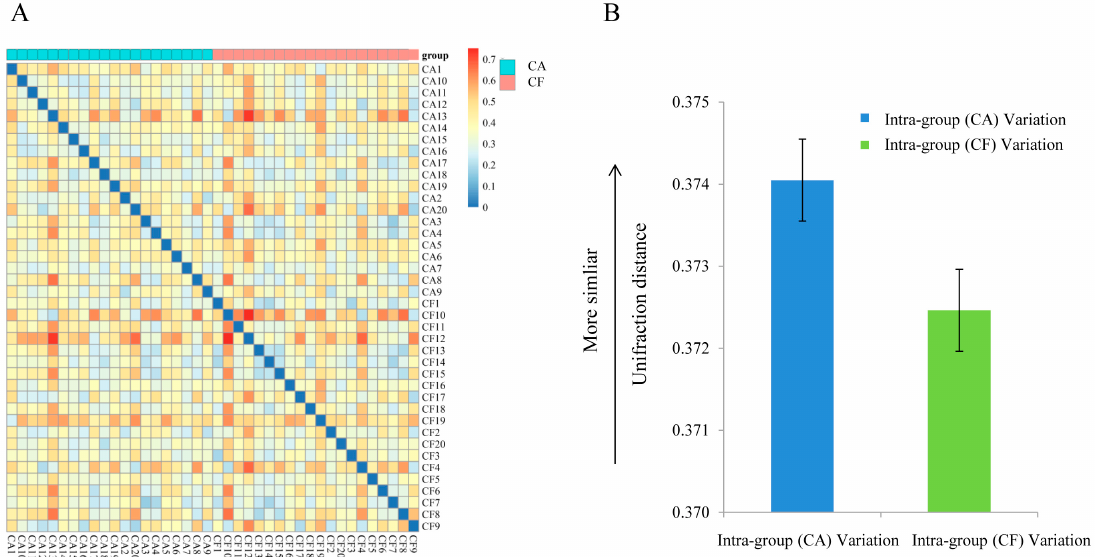
Figure 3. Comparison of community structures within and between the caries-affected (CA) and caries-free (CF) groups. ( A ) Heatmap of the weighted UniFrac distance within and across the CA and CF groups; ( B ) The weighted UniFrace distance values (mean ± SD) of the CA and CF groups.